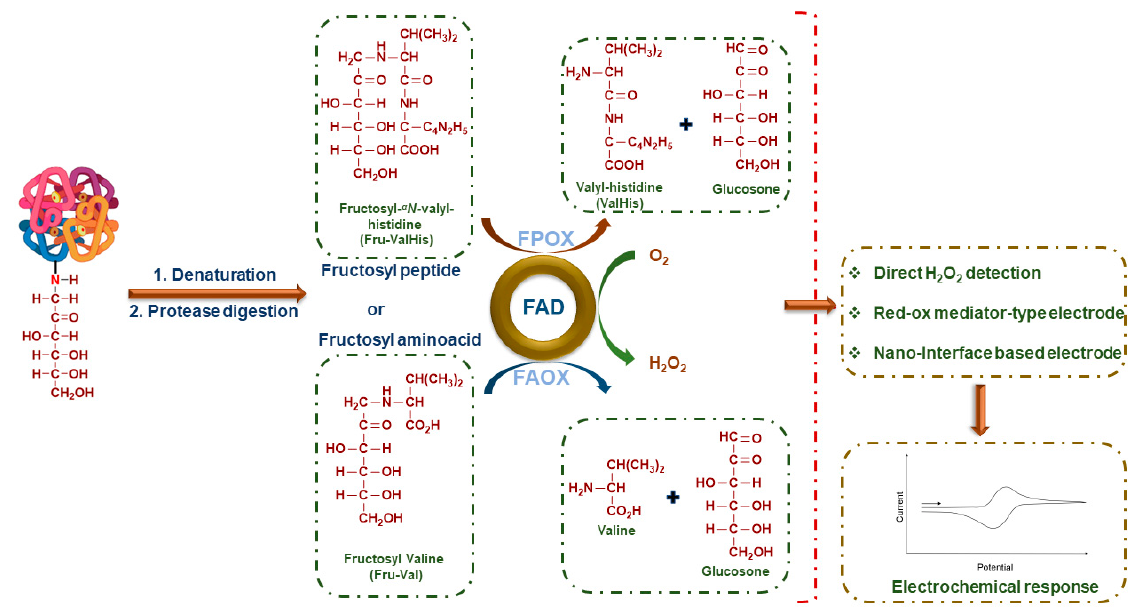
Figure 6. General representation of fructosyl amino acid oxidase (FAO) enzyme-based electrochemical sensors for HbA1c.